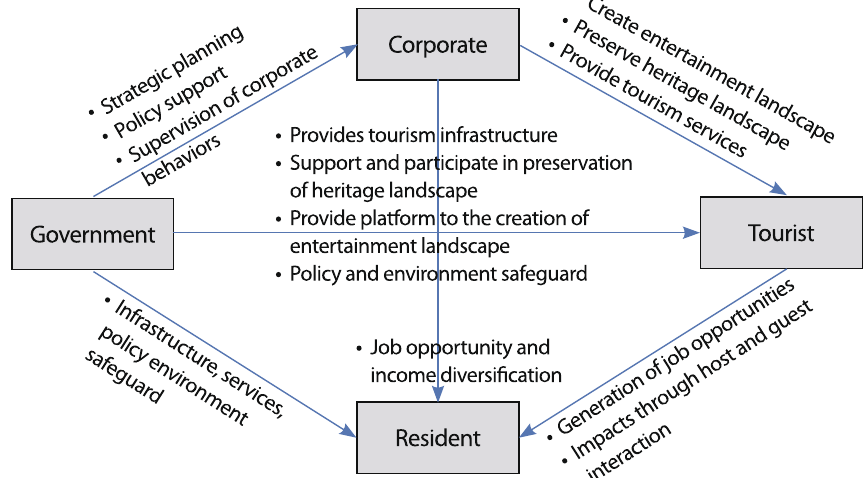
Fig. 6 Multiple stakeholder interactions in Guangfu Ancient City (Source: the